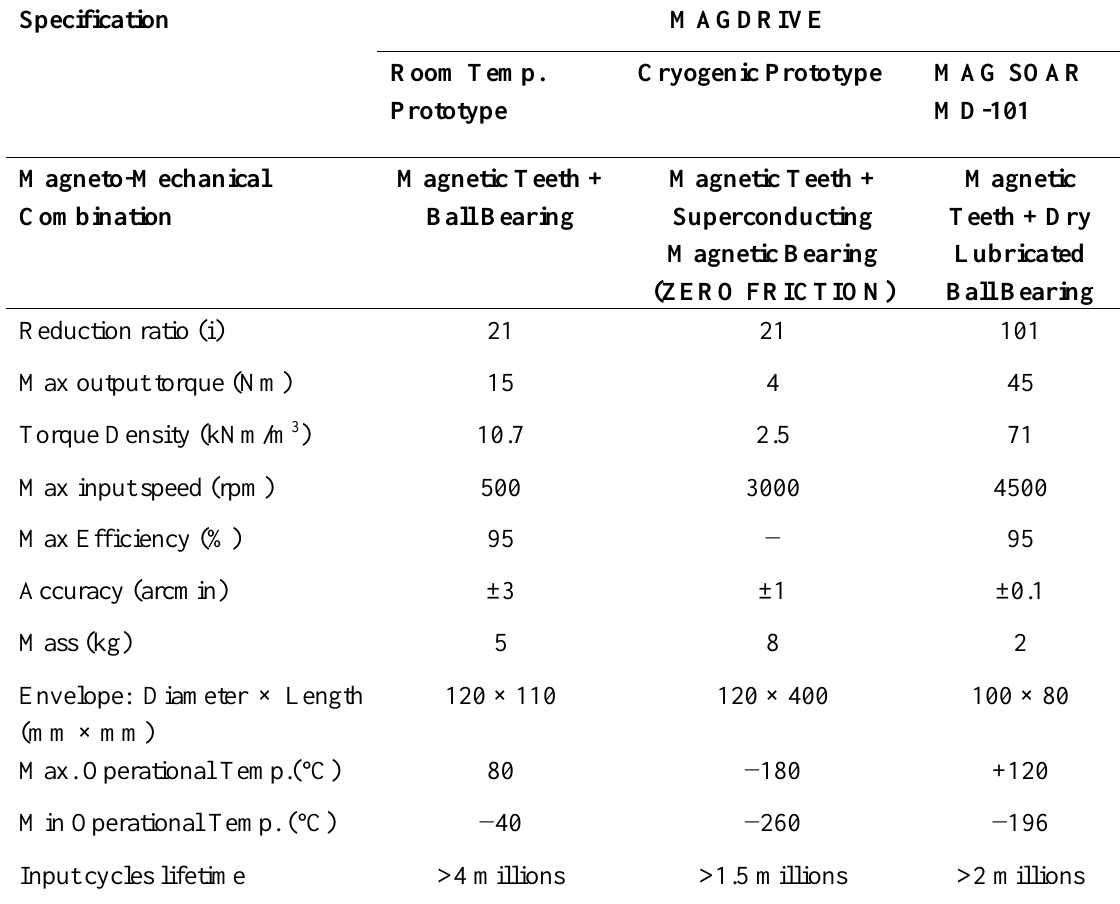
Table 2. Comparison of experimental tests on Magdrive prototypes from MAG SOAR.